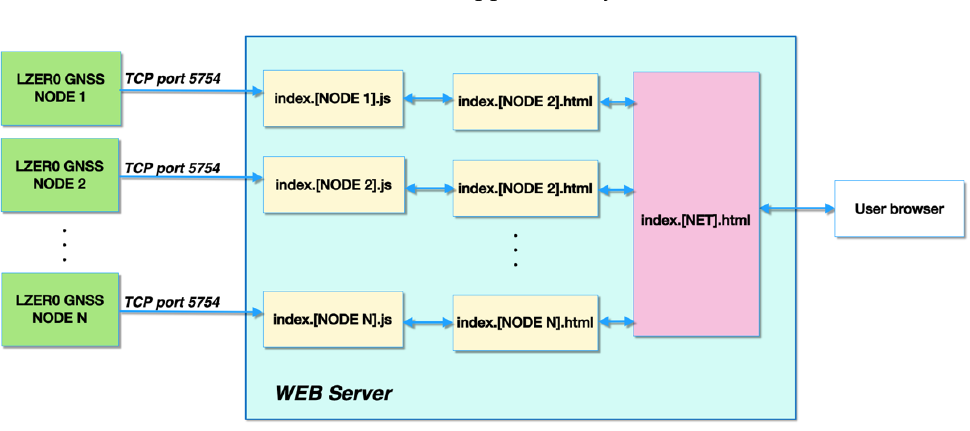
Figure 2. Scheme describing the scripts and code running on the remote server that are used to display the real-time coordinates generated by various remote LZER0 nodes (e.g., the devices of a monitoring network). More details about the scripts and their functions can be found in Supplementary Material Section SA. Table 3. Scripts that control the external software on the server side ([NODE #] is the reference identifier of a node). See Supplementary Material Section SA for more